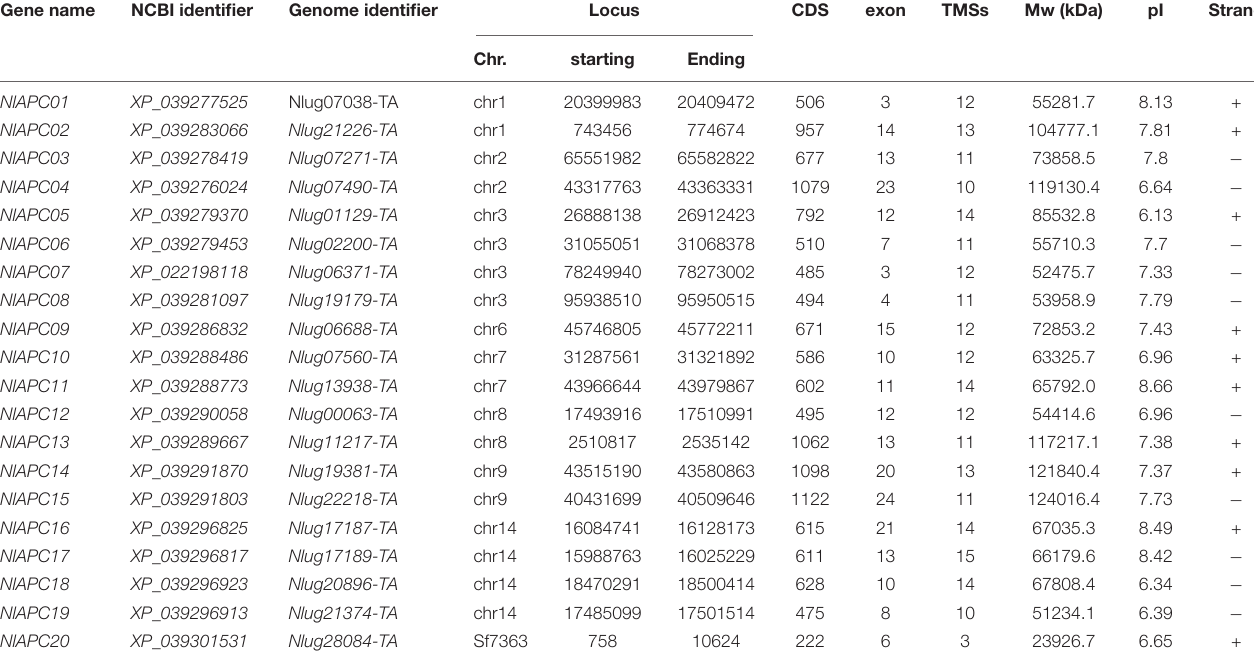
TABLE 1 | Identification and characteristics of APC transporters in